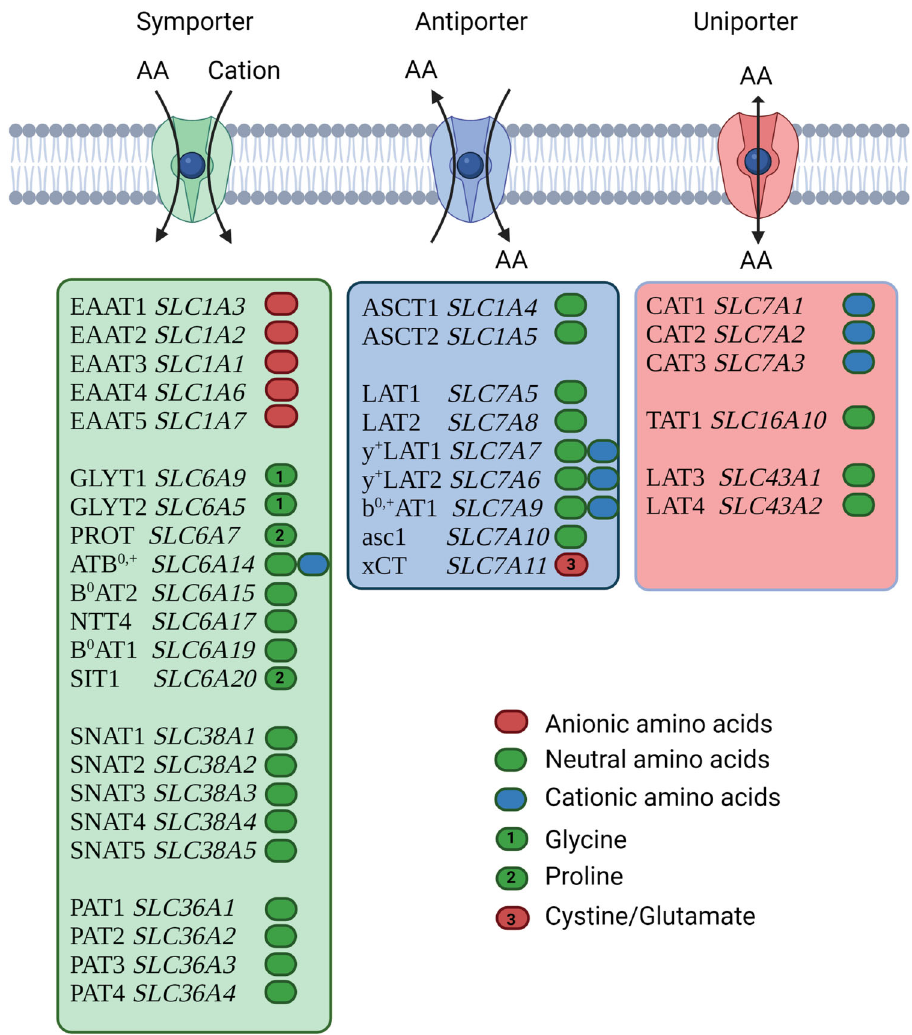
Fig. 1 Overview of plasma membrane amino acid transporters. Symporters are shown in green, antiporters in blue, and uniporters in red. Common names and solute carrier number are listed for each transporter. The substrate speci fi city of each transporters is indicated by color code (green = neutral, red = anionic, and blue = cationic). Speci fi c amino acids are labeled as